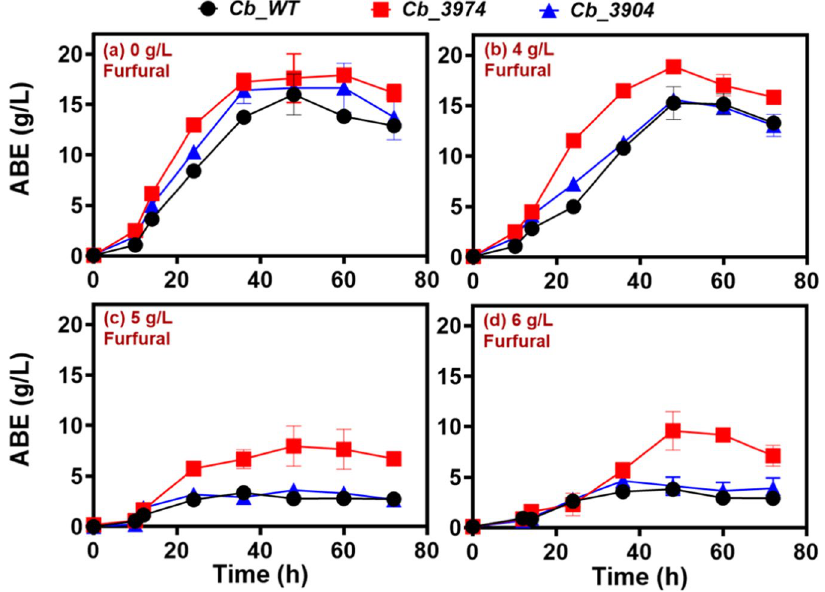
Figure 6. ABE profiles of Cb _3974, _3904, and _wild type in P2 fermentation medium supplemented with 0–6 g/L